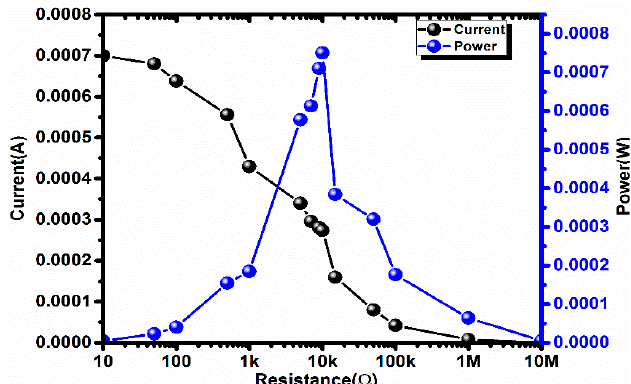
Figure 14. Measured electrical power output on different load resistances at a rotational speed of 251 rpm and temperature difference of 45 ° C.